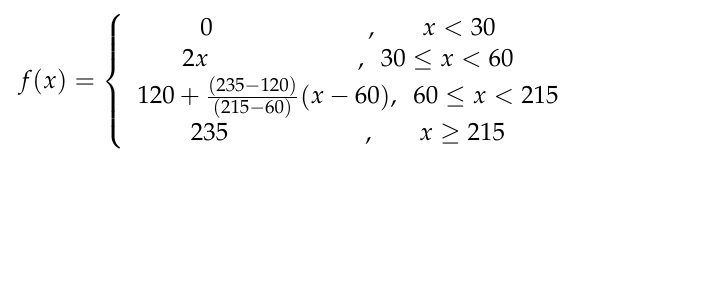
Figure 9. ( a ) Gamma transform algorithm with coefficient of 2.4; ( b ) linear stretch algorithm.